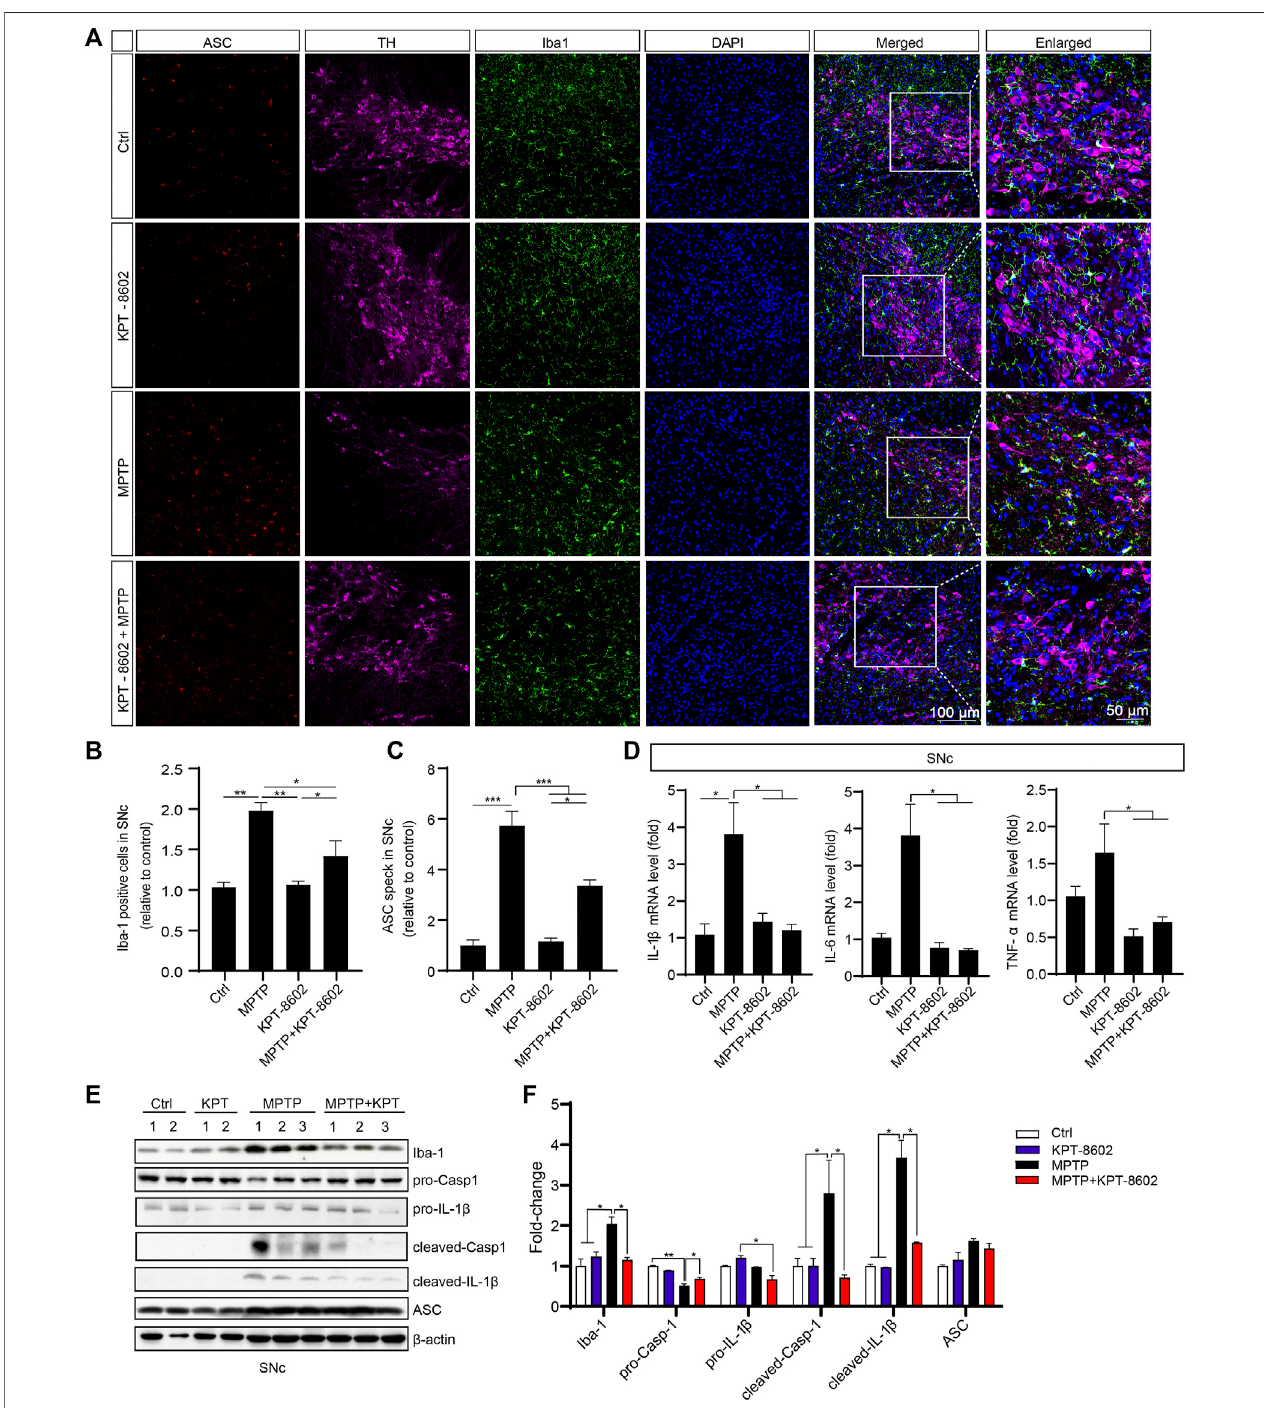
FIGURE7| KPT-8602inhibitsactivationoftheNLRP3in fl ammasome invivo . (A) SubstantianigracompactafromPDmiceadministeredKPT-8602orvehiclewere stained with an anti-Iba-1 and anti-ASC antibody to evaluate the activation of microglia and the NLRP3 in fl ammasome (5 mice per group). The number of Iba-1-positive cells (B) and ASC specks (C) was analyzed by ImageJ. Scale bars, 100 μ m for low-magni fi cation images and 50 μ m for high-magni fi cation images, respectively. (D) Expression levels of IL-1 β , IL-6, and TNF- α in the SNc were detected by real-time PCR. The expression of Iba-1, pro-caspase-1, pro-IL-1 β , cleaved caspase-1, cleaved-IL-1 β , ASC, and β -actin in the SNc was analyzed by Western blotting (E) , and the gray value of their bands was analyzed by ImageJ (F) . (* indicates p < 0.05, ** indicates p < 0.01, *** indicates p < 0.001 by one-way ANOVA).